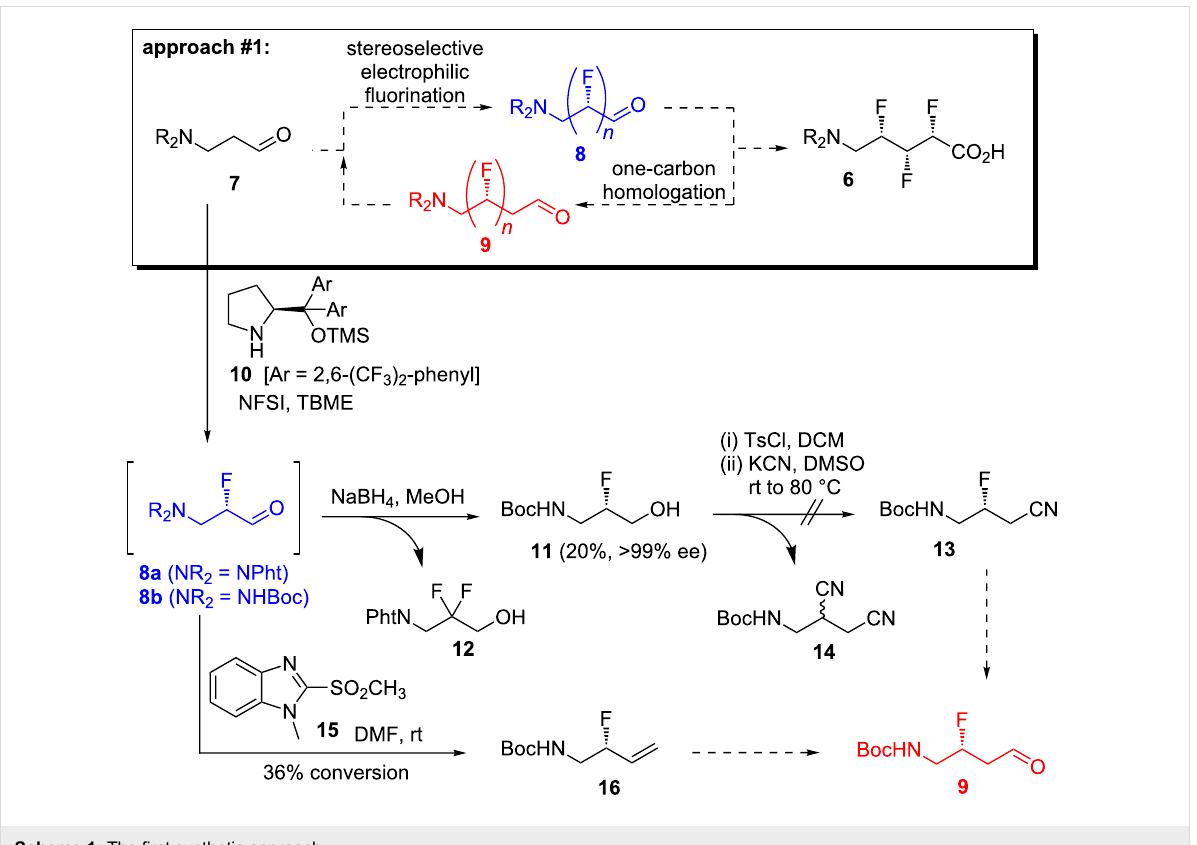
Scheme 1: The first synthetic